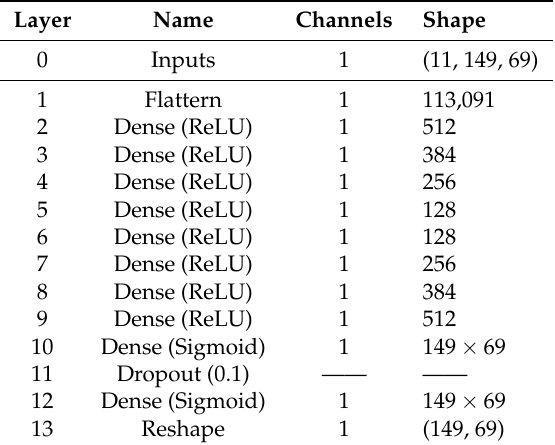
Table 4. Configuration of parameters for